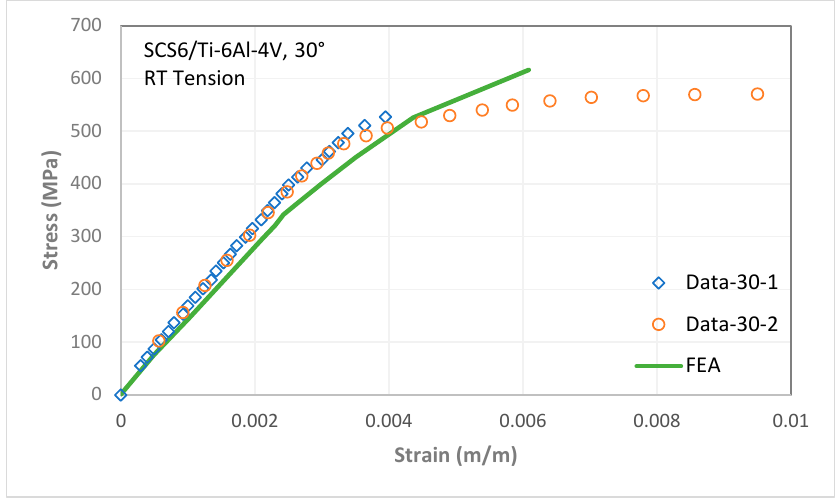
Figure 10. Stress-strain response for 30° off-axis at 23 °C.